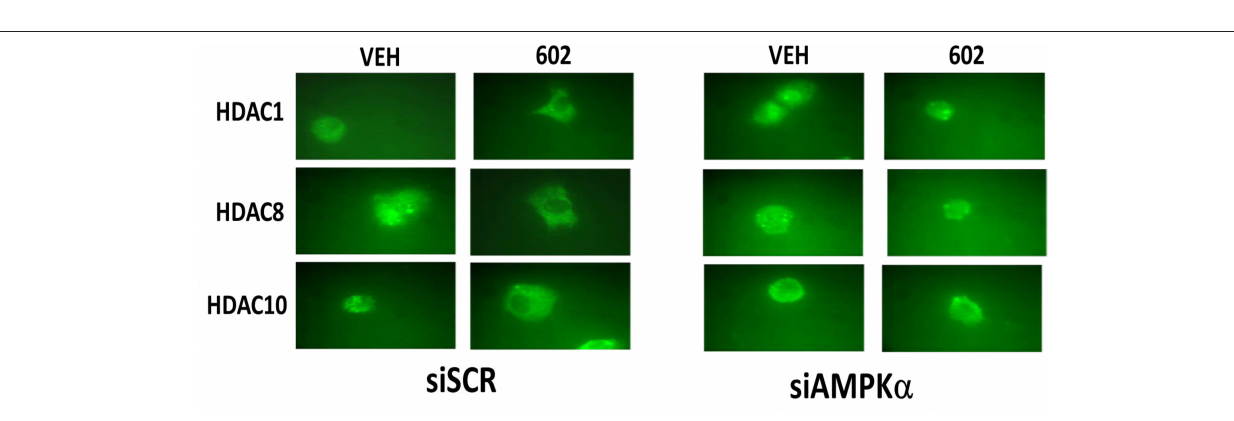
lesions. Harmine can elevate micronuclei levels in eukaryotic cells and in the Ames test, harmine could induce frameshift mutations in S. typhimurium strains TA97 and TA98